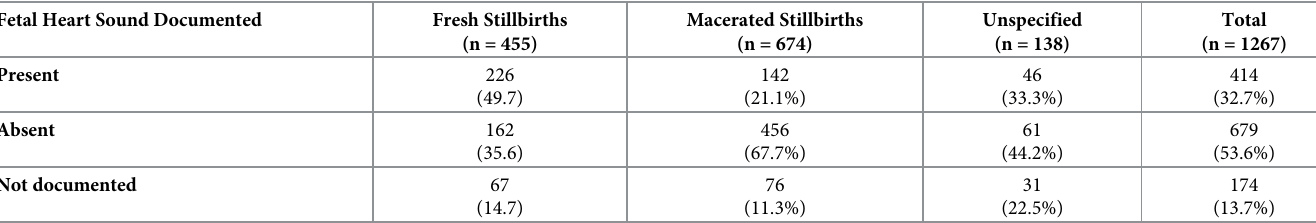
Table 3. Time of death.